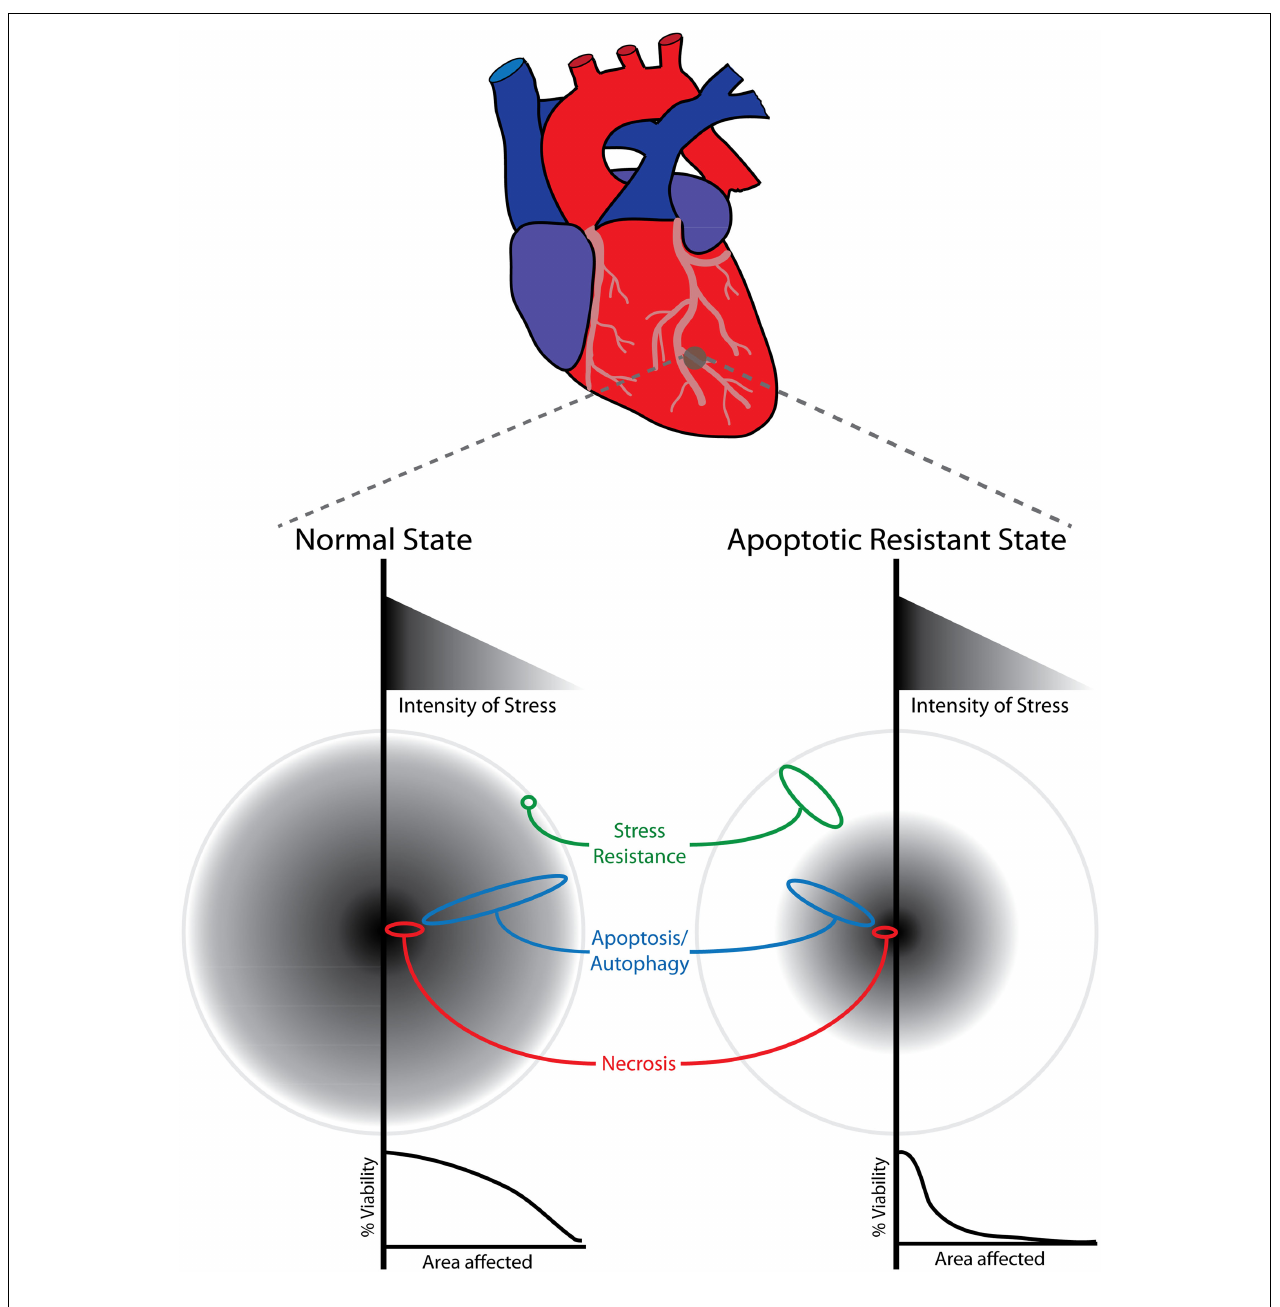
stressed cells undergo cell death that appears to include apoptosis and possibly autophagic death. Loss of viability is more pronounced as we move closer to the site of the most intense stress.Transgenic animals that overexpress an anti-apoptotic gene in a cardiac specific manner represent an apoptotic resistant state (right side). Identical levels of stress generated in the hearts of these animals leads to significant reduction in the zone of dead